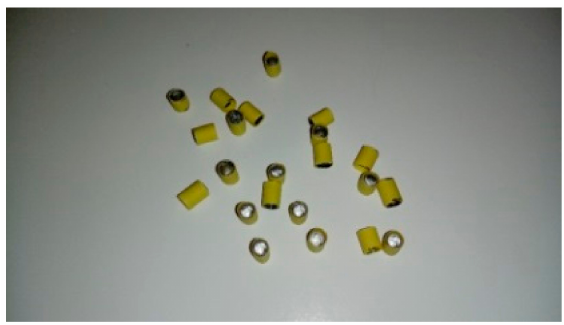
Figure 2. Heat-shrink sheaths for wire connections.